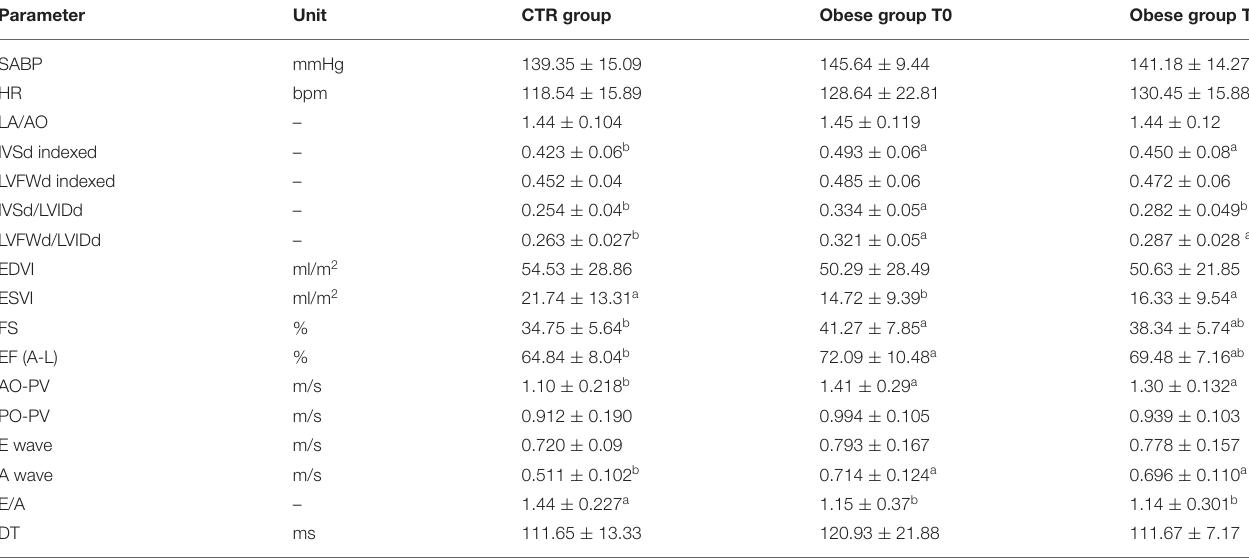
TABLE 4 | Systolic blood pressure, heart rate, and echocardiographic findings in the control (CTR) and obese groups before and after the weight loss program (WLP).